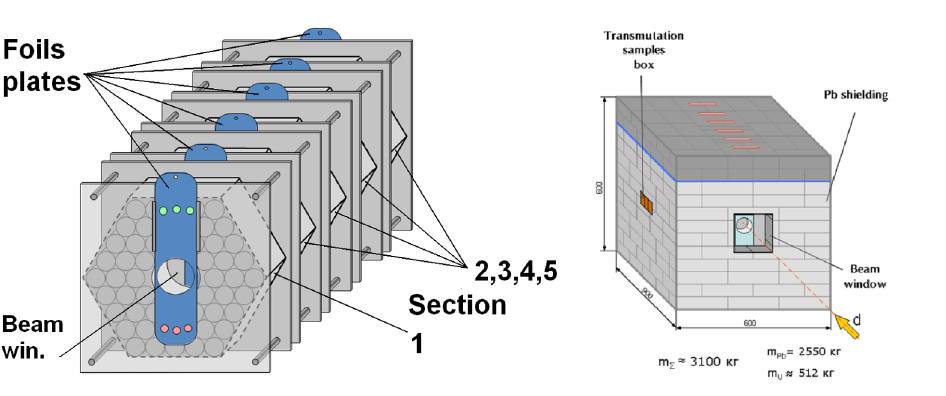
Figure 1. Scheme of Quinta assembly. On the left there is a view on the uranium target with supporting structures and plastics used for sample placement (detector’s plates), on the right there is a view on the lead shielding enfolding the target with marked transmutation samples in the box (window) to locate actinides samples in the